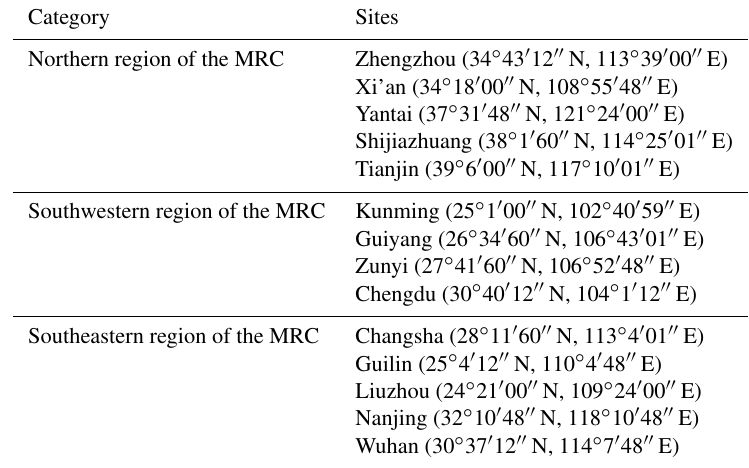
Table 1. GNIP stations used for the comparison of the seasonal precipitation amount and δ 18 O p in the